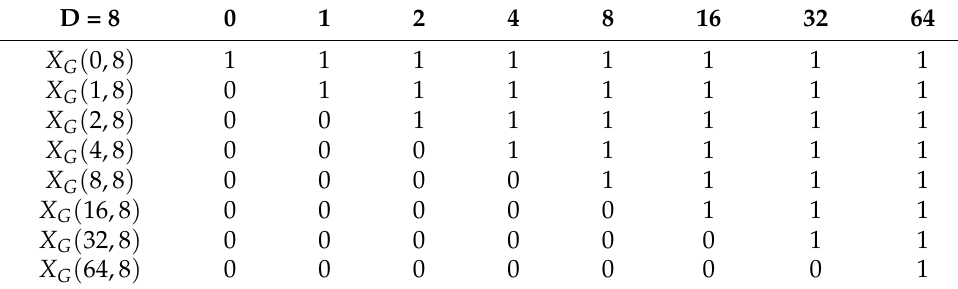
Table 3. All possible values encoded with method X G